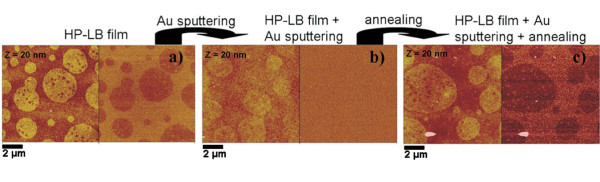
AFM images of the three steps of sample preparation: (a) HP-LB film of PnBuA-b-PAA; (b) HP-LB film covered with Au nanoparticles deposited by sputtering; (c) annealed bilayer (115°C, 15 min).